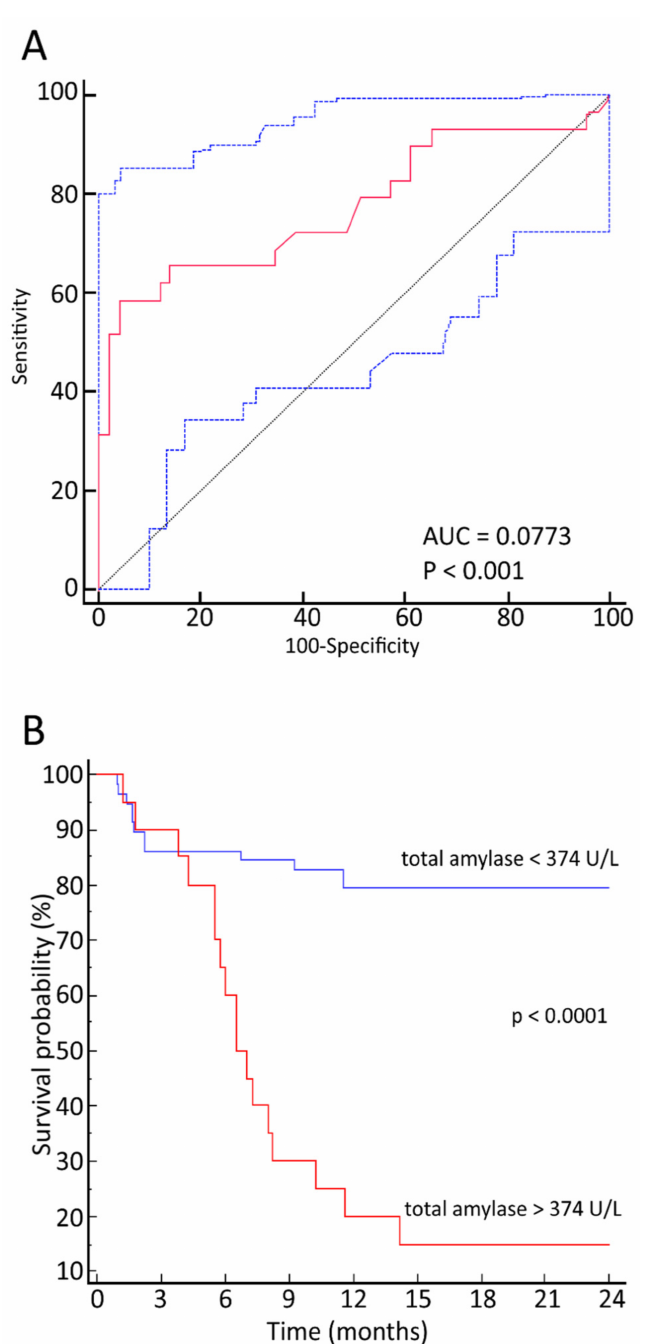
Figure 2. ( A ) Receiver operative characteristics curves of total amylase diagnostic performance in predicting the overall survival after hematopoietic stem cell transplantation with total body irradiation-based conditioning. ( B ) Kaplan–Meier curves for overall survival of patients with total amylase values below 374 U/L (blue line) and above 374 U/L (red